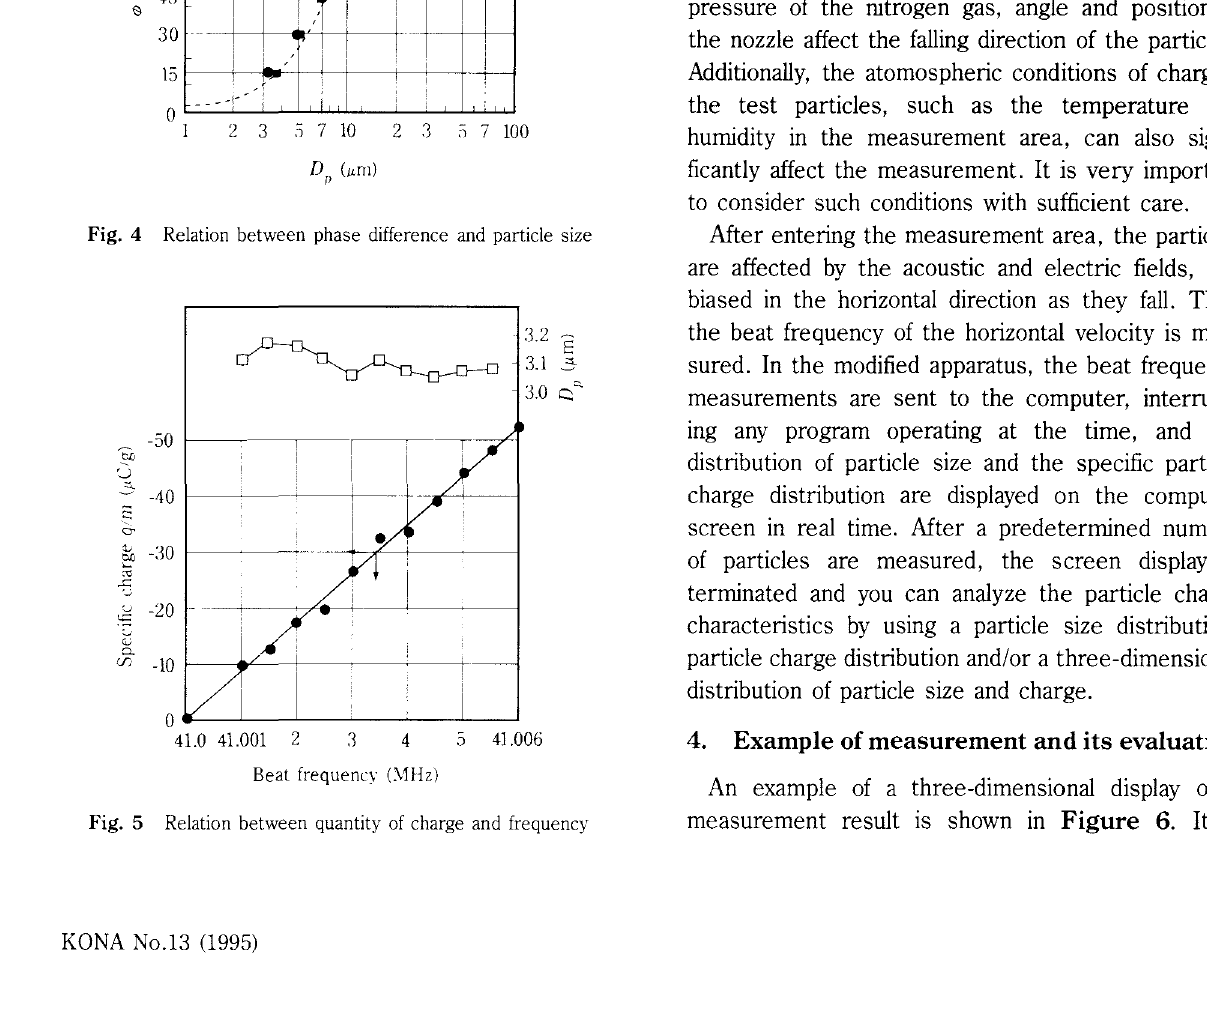
Fig. 5 Relation between quantity of charge and frequency